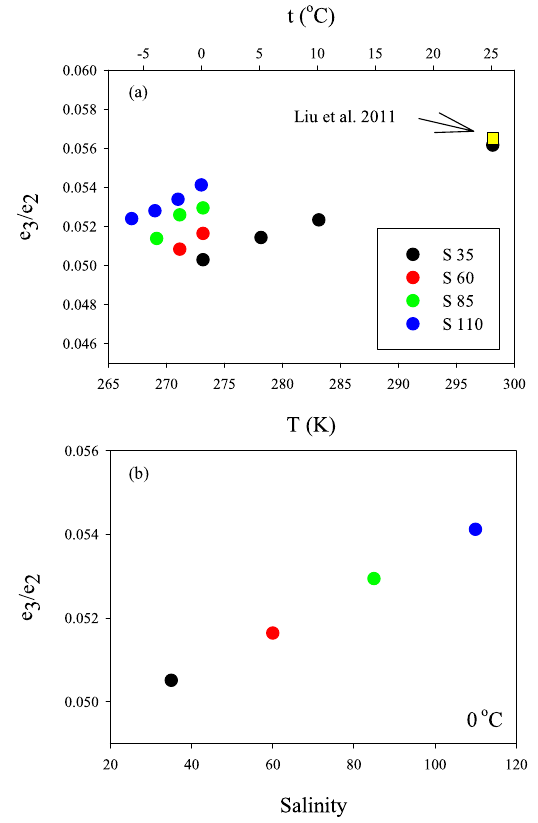
Figure 4. Values of e 3 /e 2 ( a ) as a function of temperature, and ( b ) salinity at 0 °C. The measurements were obtained at pH 12 in solutions with near-seawater composition and ionic strength equivalent to salinities 35, 60, 85, and 110. The yellow square in panel (a) represents the e 3 /e 2 value reported by Liu et al . 30 for S = 35 and T = 298.15